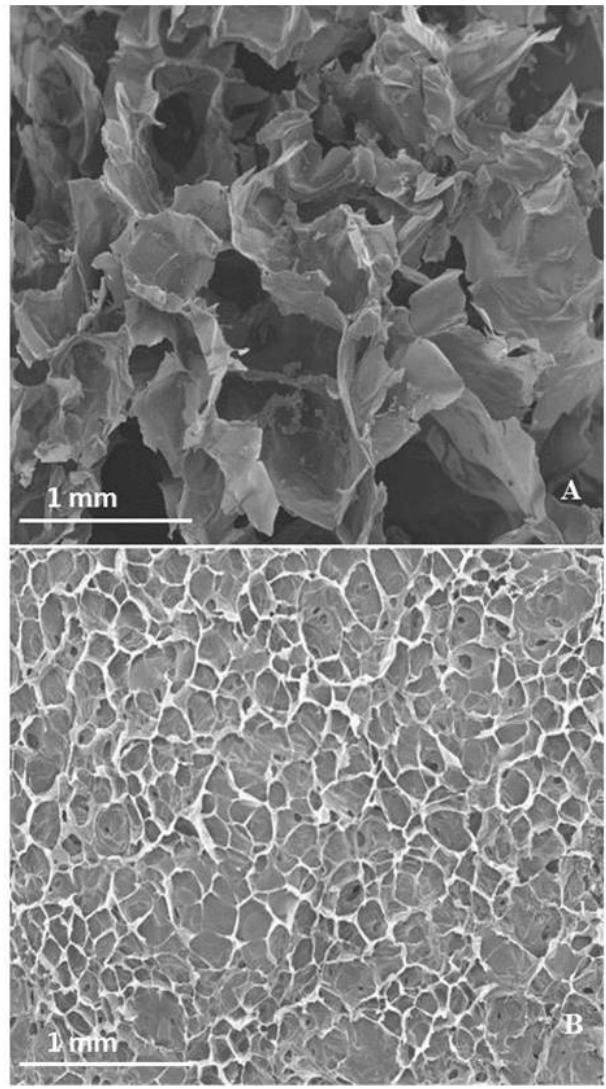
Figure 3. SEM micrographs of lyophilized WEAX gel ( A ) and WEAX gel containing B. longum ( B ) at 35×